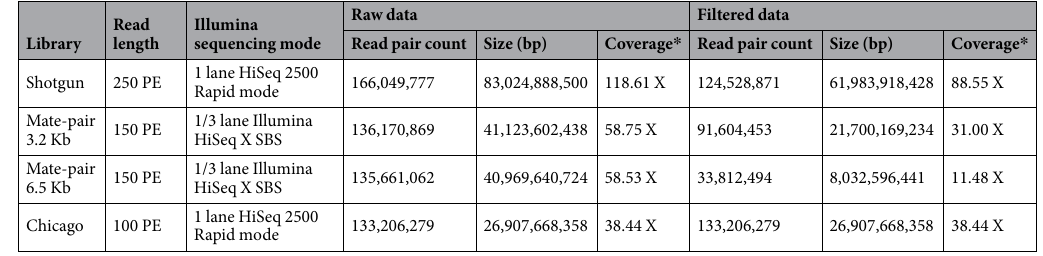
Table 1. Summary of data types and Illumina read statistics used in assemblies. * Genome Size =